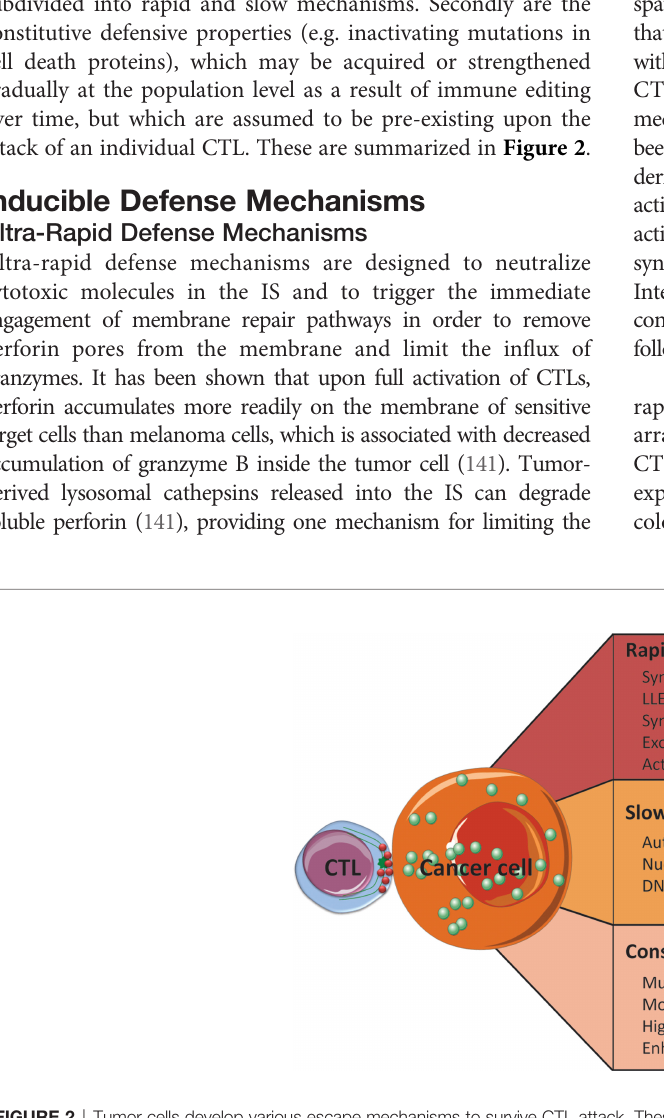
FIGURE 2 | Tumor cells develop various escape mechanisms to survive CTL attack. These mechanisms can be divided into three categories: rapid, slow, and constitutive. Several examples of each category are outlined